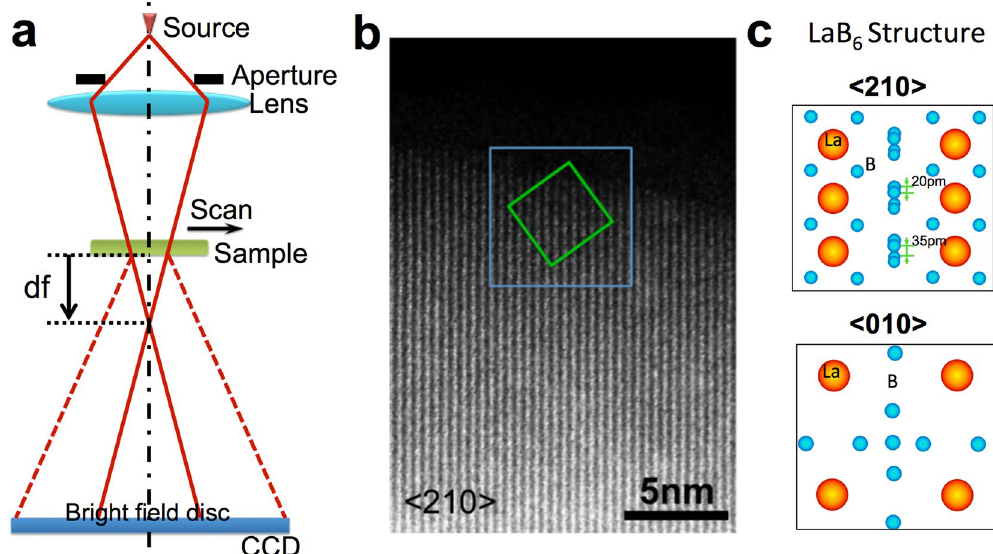
Figure 1. ( a ) Schematic of the experimental configuration used for ptychographic reconstruction. ( b ) HAADF image of a LaB 6 nanoparticle oriented along a < 210 > direction. The green box indicates the region where the object function shown in Fig. 2a was restored using the ePIE algorithm. The blue box indicates the region where the HAADF image shown in Fig. 2b was acquired ( c ) Projected atomic models of LaB 6 along < 210 > (Top) and < 010 > (Bottom)